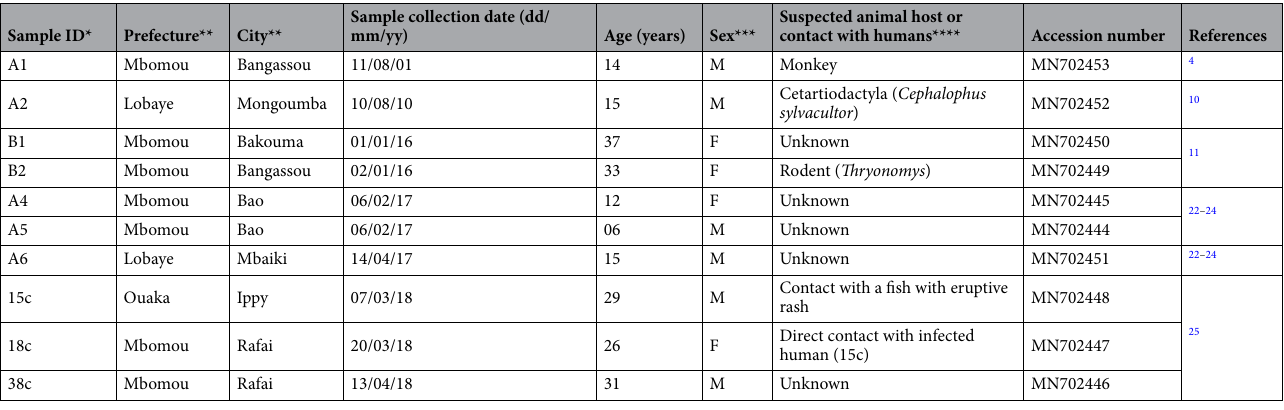
Table 1. Metadata on monkeypox virus (MPXV) case samples. *Sample ID assigned during sample collection from patients with MPXV infections in the CAR on the date indicated in the ‘Sample collection date’ column.